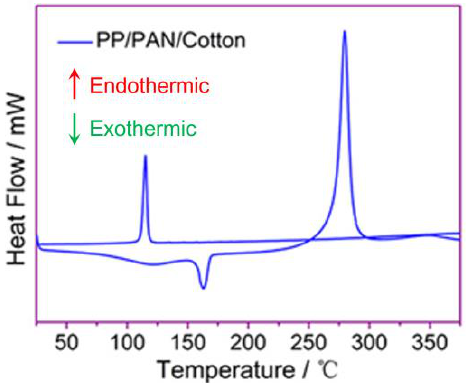
Figure 6. DSC curves of modified PP/PAN/cotton fibers composite membrane.